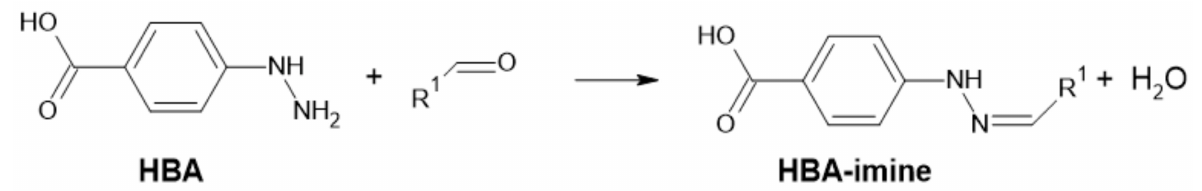
Figure 17. Derivatization reaction of 4-HBA and aldehyde (Adapted with permission from ref. [10]. Copyright 2018